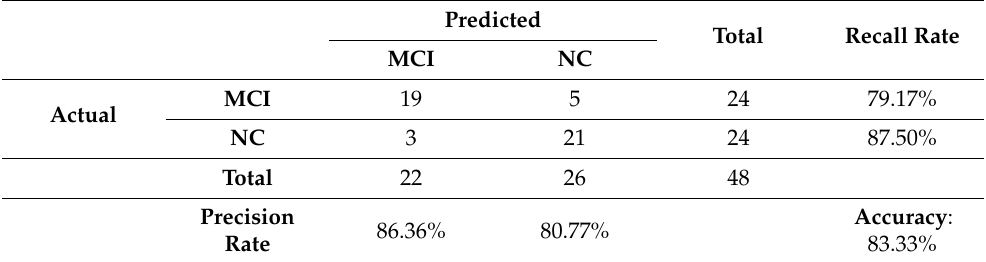
Table 8. Confusion Matrix with Precision and Recall rates using game performance only.